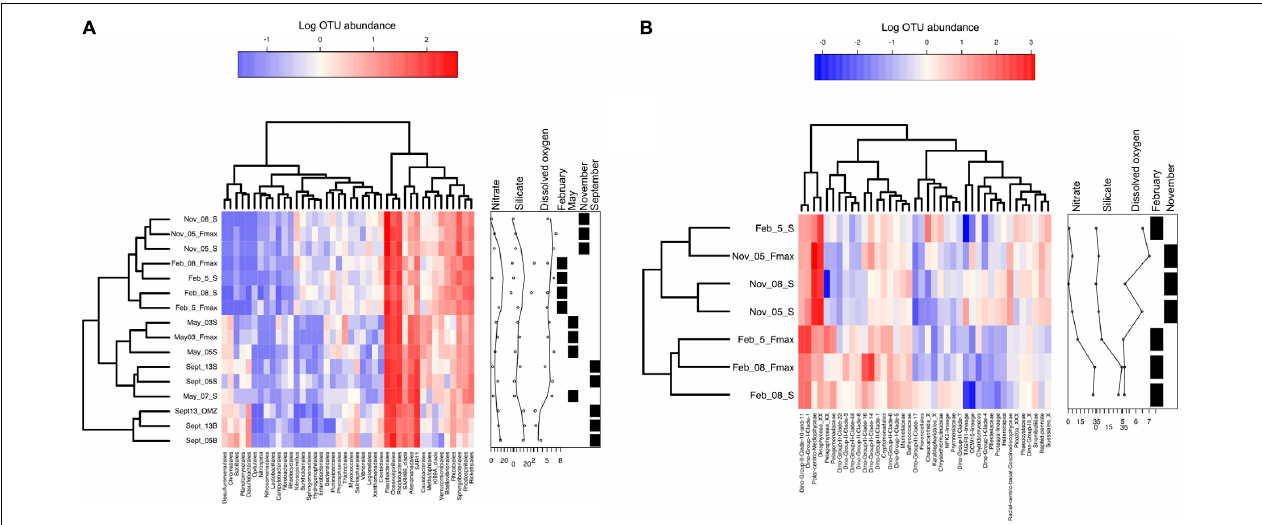
FIGURE 4 | Similarities among samples from the St Helena Bay Monitoring Line in terms of the abundances of the top OTUs. Heatmaps illustrate log transformed OTU abundance data of the top 40 orders for (A) 16S (May 2015-February 2016), (B) 18S (November 2015-February 2016). Boxes to the right of each heatmap indicate nitrate, silicate and dissolved oxygen (DO) concentrations associated with each sample. The samples are also classed in terms of months sampled through the presence of black boxes. Samples are clustered through the nearest neighbor